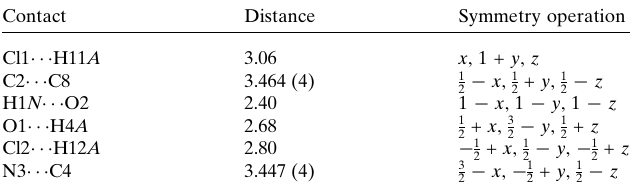
1.3500 (blue) a.u. is shown in Fig. 6. The white surface indi- cates contacts with distances equal to the sum of van der Waals radii, and the red and blue colours indicate distances shorter (in close contact) or longer (distant contact) than the van der Waals radii, respectively (Venkatesan et al. , 2016). The dark- red spots on the d surface arise as a result of short inter- norm atomic contacts (Table 2), while the other weaker inter- molecular interactions appear as light-red spots. The red points, which represent closer contacts and negative d norm values on the surface, correspond to the C—H (cid:3) (cid:3) (cid:3) O and C— H (cid:3) (cid:3) (cid:3) Cl interactions. The shape-index of the Hirshfeld surface is a tool for visualizing the (cid:2) – (cid:2) stacking by the presence of adjacent red and blue triangles; if there are no such triangles, then there are no (cid:2) – (cid:2) interactions. The plot of the Hirshfeld